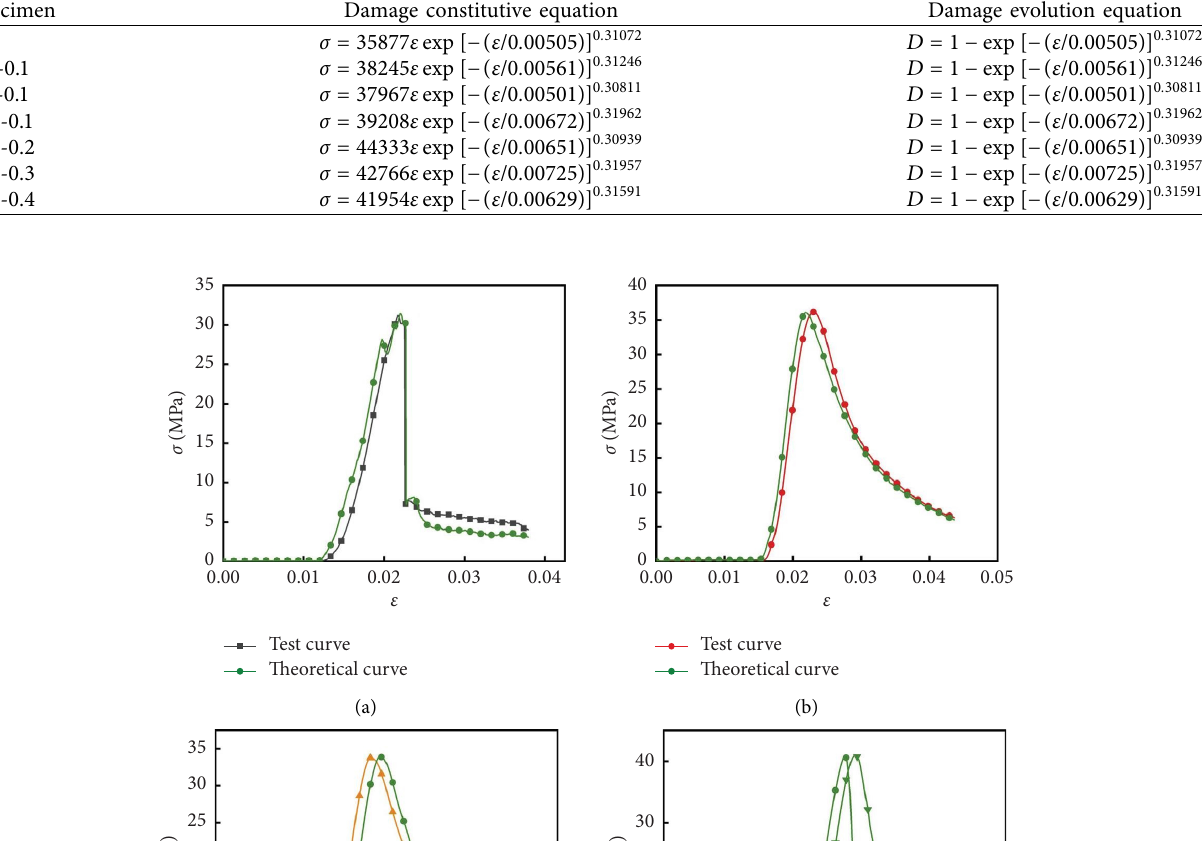
Table 4: Damage constitutive equation and damage evolution equation of